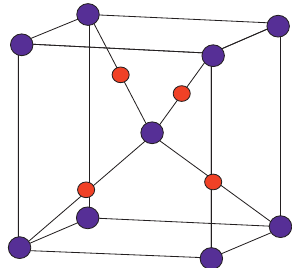
Figure 1: Unit cell of Cu